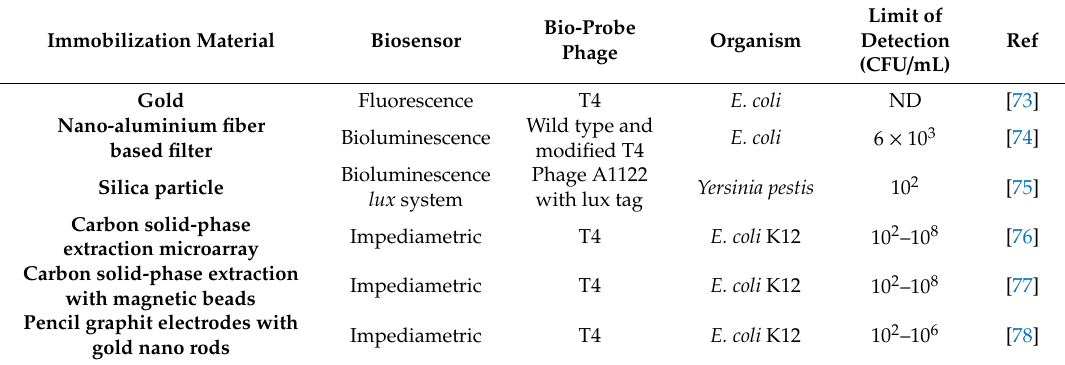
Table 3. The nanoparticle phage-based biosensors in the diagnosis of pathogens according to type of phage, type of sample, duration of diagnosis and limit of